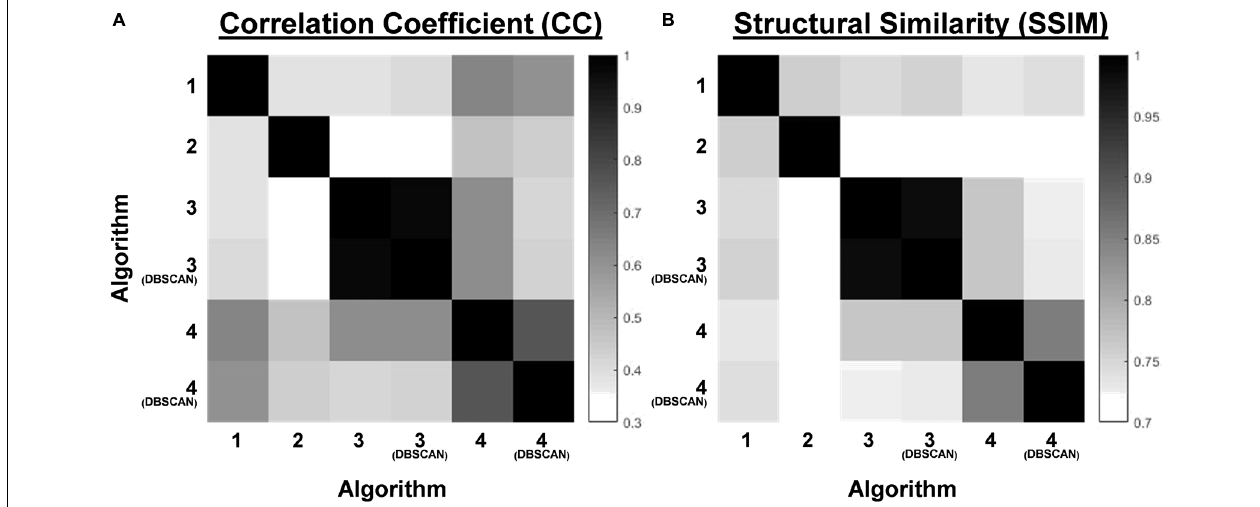
FIGURE 4 | (A) The correlation coefficient (CC) of the PSD maps between the Algorithms 1–4 and Algorithm 3 and 4 with DBSCAN based on default parameter settings. (B) The Structural Similarity Index (SSIM) of the PSD maps between the Algorithms 1–4 and Algorithm 3 and 4 with DBSCAN based on default parameter settings.